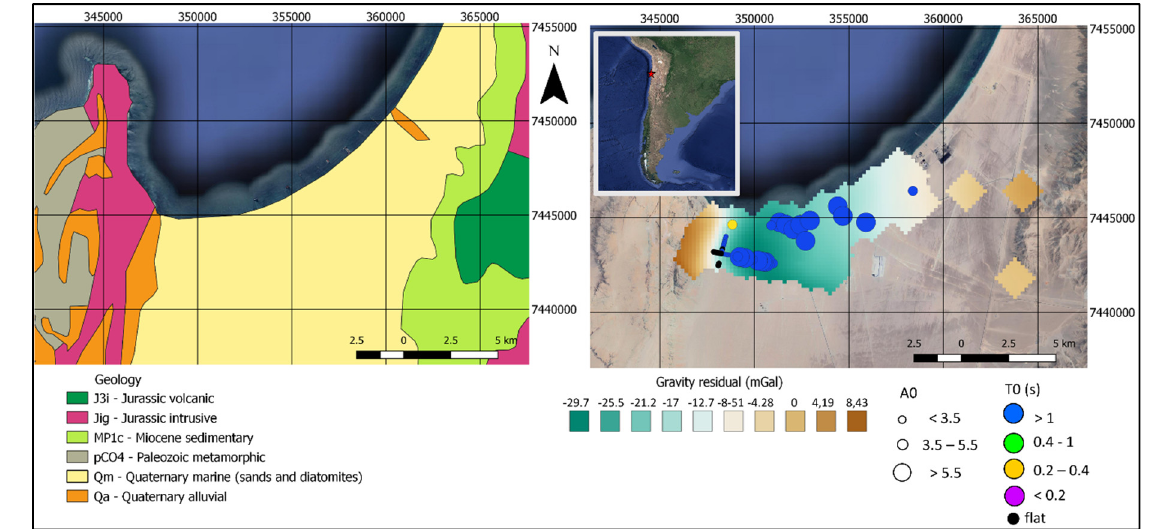
Figure 4. Mejillones. Left panel: Simplified geology of the city adapted from Chilean geological map 1:1,000,000 [36]. Right panel: Main results of the geophysical campaign [8,36]. The color grid shows the gravity residuals in mGal. The color points show the H/V results. Color indicates the predominant period (T0) in seconds and the size indicates the amplitude (A0) of the H/V curve.